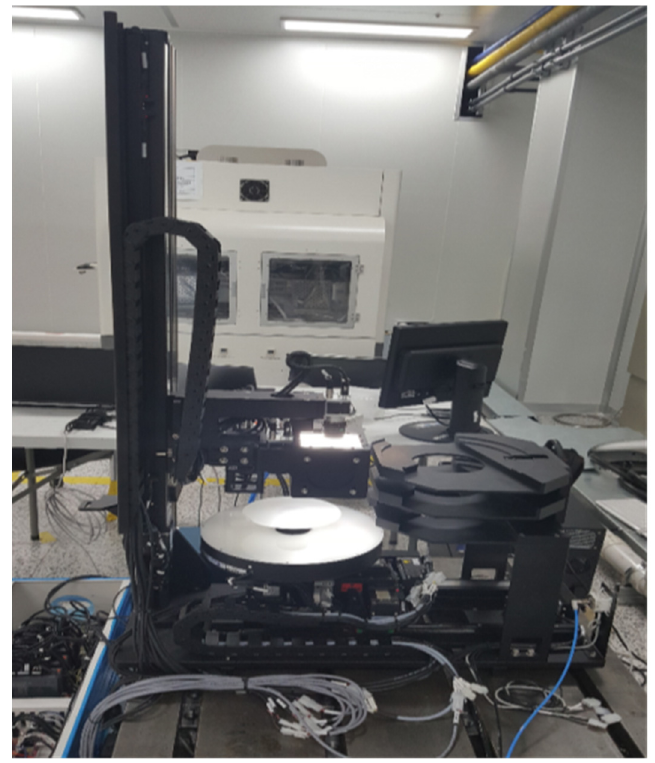
Figure 12. Sapphire wafer ‐ bonding system with vision aligner.